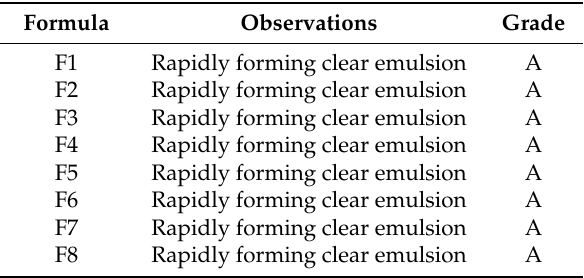
Table 6. Visual Observations of the Dispersibility Test for Various OLM SNEDDS Formulae.